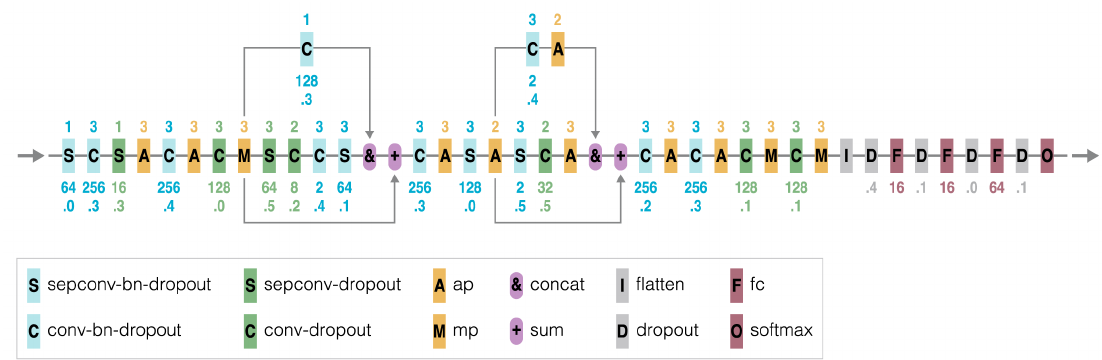
Figure 7. Example of a network automatically designed by VGNet. High-level architectural overview of model “v2m2”. Numbers indicate from top to bottom: ( i ) “S” and “C” blocks: size, number of filters and dropout rate; ( ii ) “A” and “M” blocks: size; ( iii ) “D” dropout rate; and ( iv ) “F” number of